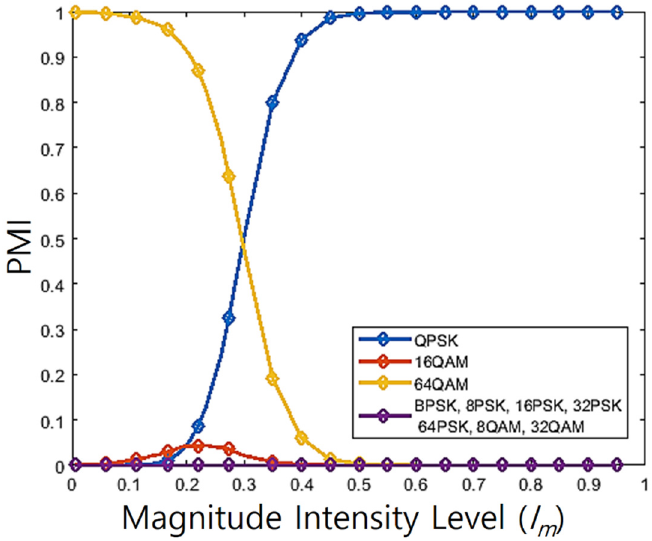
Figure 16. PMI evaluation with varying I m and I p = 1.